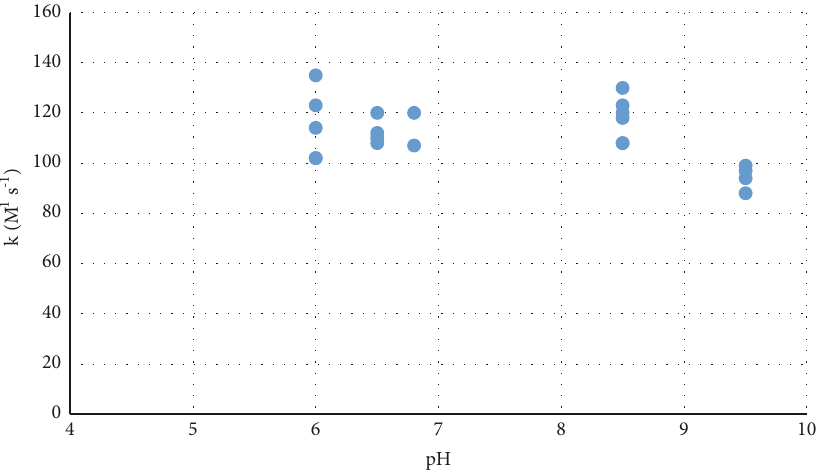
Figure 4: Variation of the MC-LA second order rate constant from pH 6 to 9.5. Table 4: Apparent rate constants determined by three methods at 25 ∘ C and 35 ∘